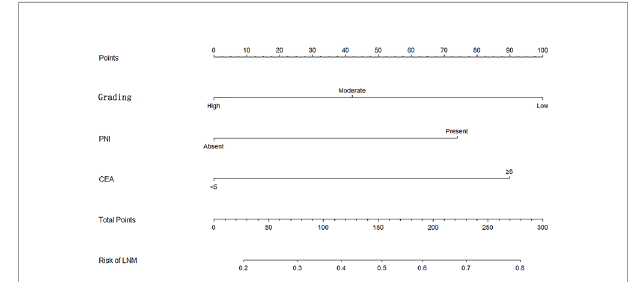
FIGURE 2 | Nomogram constructed according to clinicopathological parameters.